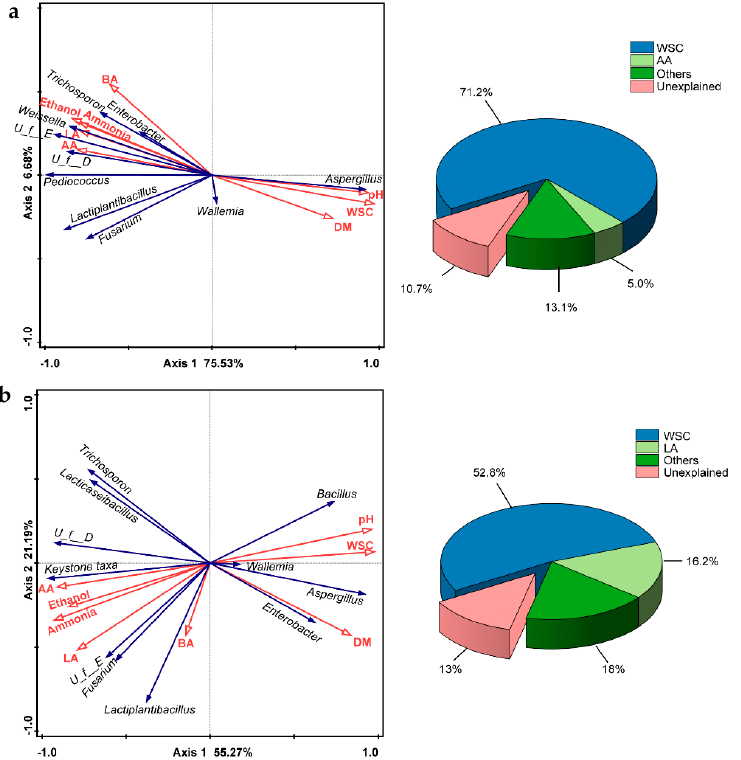
Figure 4. Redundancy analysis (RDA) of relationships between dominant taxa and physicochemical parameters, and ex- plained percentages of variance for each physicochemical parameter. ( a ) Without Lactiplantibacillus plantarum inoculation; ( b ) with Lactiplantibacillus plantarum inoculation. U_f__E , unclassified_f__Enterobacteriaceae ; U_f__D , unclassi- fied_f__Dipodascaceae ; keystone taxa include Lactiplantibacillus and Lacticaseibacillus. DM, dry matter; WSC, water-soluble carbohydrates; LA, lactic acid; AA, acetic acid; BA, butyric acid.